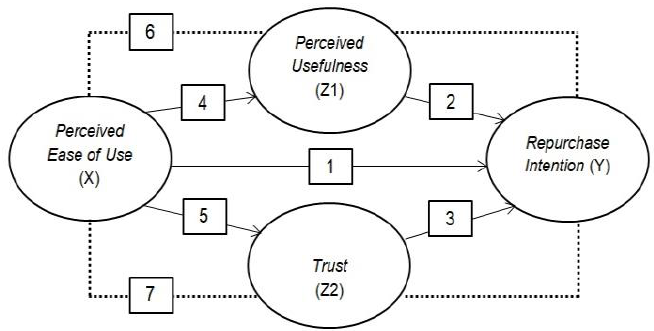
Figure 1: Research Framework and